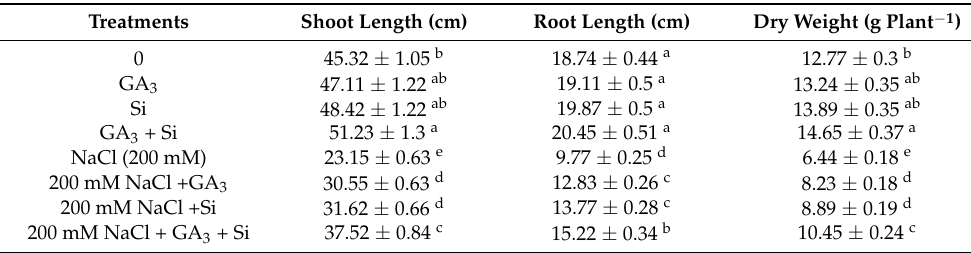
Table 1. Result of gibberellic acid (GA 3 ) and silicon (Si) application on shoot length, root length and dry weight of B. juncea cultivated under NaCl salt stress.